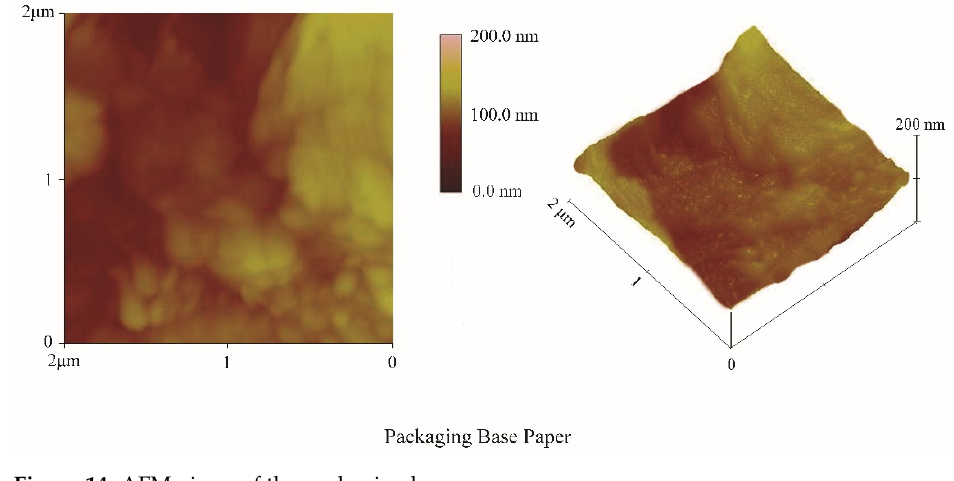
Figure 14. AFM views of the packaging base paper.